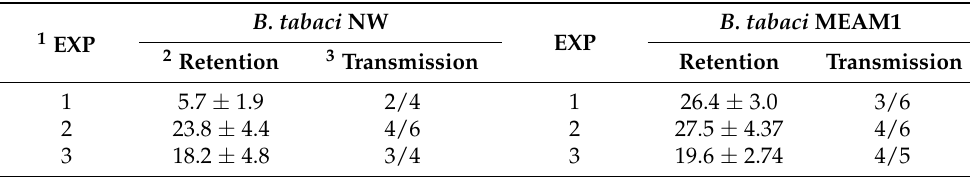
Table 1. Foregut retention and transmission of greenhouse (GH)-maintained LCV by B. tabaci